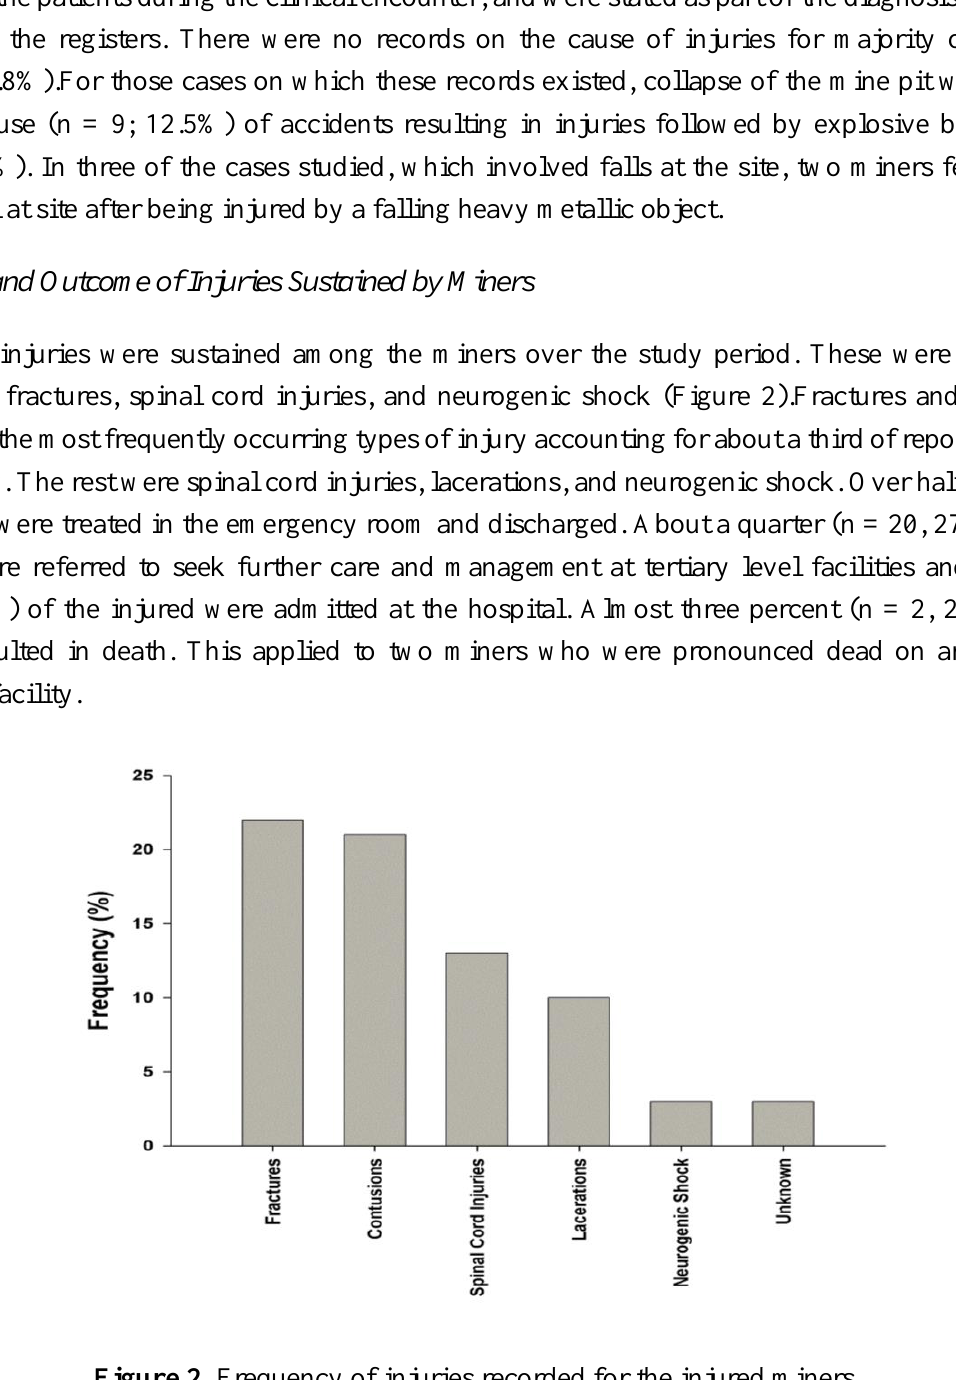
Figure 2. Frequency of injuries recorded for the injured